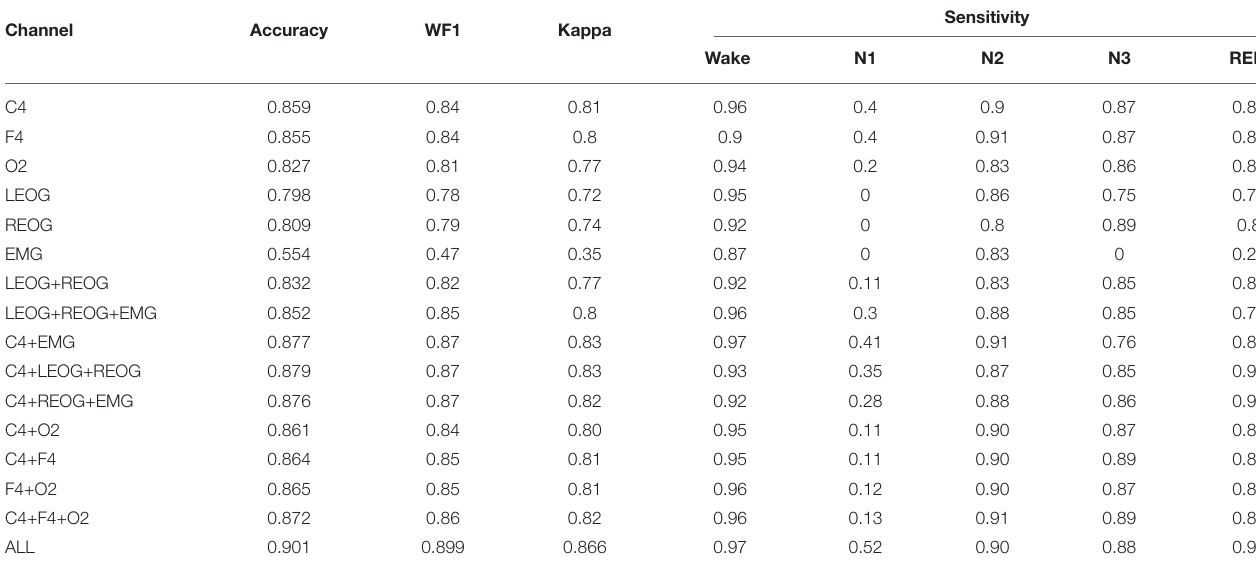
TABLE 6 | The experimental results for different channels and channel combinations. Channel